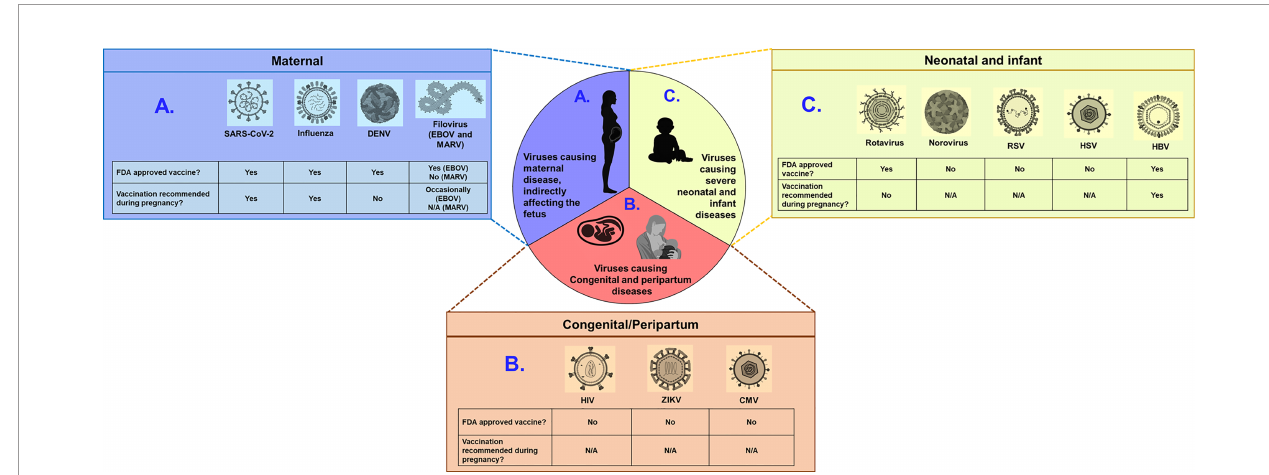
FIGURE 1 | Examples of viruses with the potential to cause severe disease in pregnant women, fetuses, and infants. Viruses can be broadly categorized into three groups: (A) those causing severe maternal disease, indirectly affecting the fetus (SARS-CoV-2, In fl uenza, DENV and Filovirus) (B) those vertically transmitted from mothers to fetus causing congenital defects (HIV, ZIKV, and CMV) and (C) those causing severe disease outcomes in infants and neonates (rotavirus, norovirus, RSV, HSV and HBV). Schematic depicts whether FDA approved vaccine is available and whether such vaccines are recommended for pregnant women, for each virus. N/A indicates not applicable, due to unavailability of approved vaccines. Of note, EBOV vaccine is occasionally recommended for pregnant women, when bene fi t outweights risks. Figure constructed using